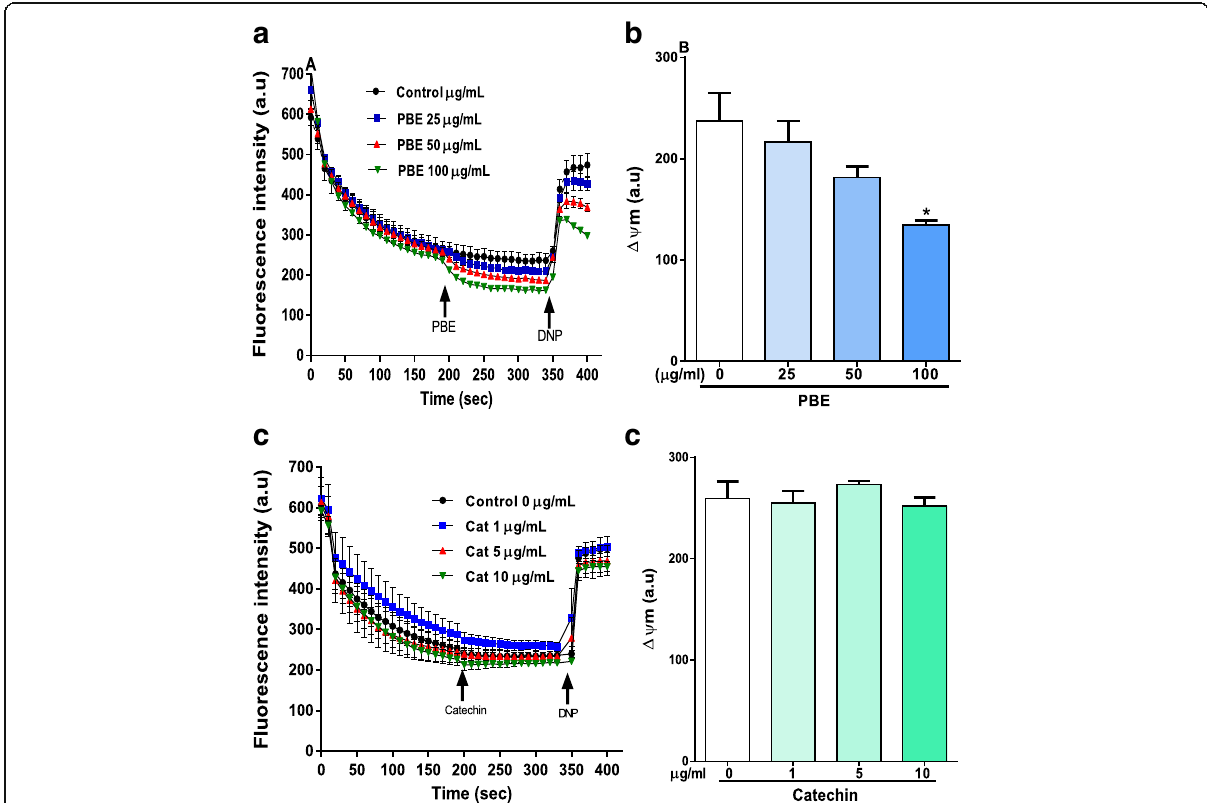
Fig. 4 Effects of Parkia biglobosa leaf extract (PBE) ( a and b and catechin ( c and d ) respectively on membrane potential difference of isolated liver mitochondria. Data is presented as mean ± SEM of three assays performed in triplicates using independent mitochondrial preparations. * P < 0.05 vs 0 μ